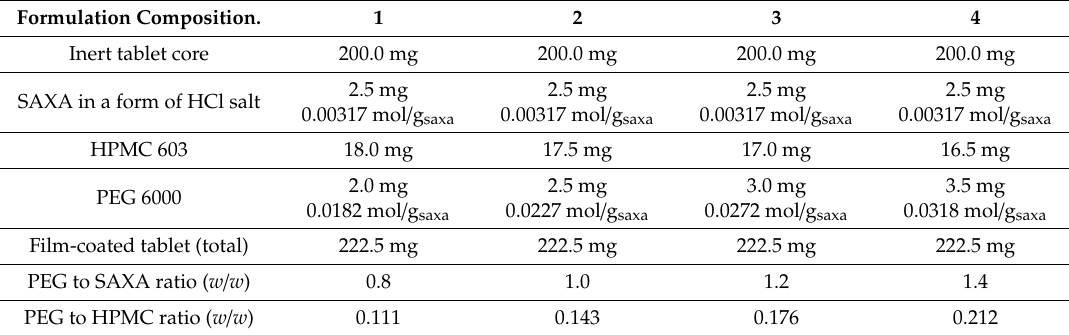
Figure 1. A scanning electron microscope (SEM) image of a film-coated tablet cross-section (magnification 100 × ); ( a ) active film-coat, ( b ) inert tablet core. Table 1. Comparison of formulation composition differences of film-coated tablets used in the stability study.